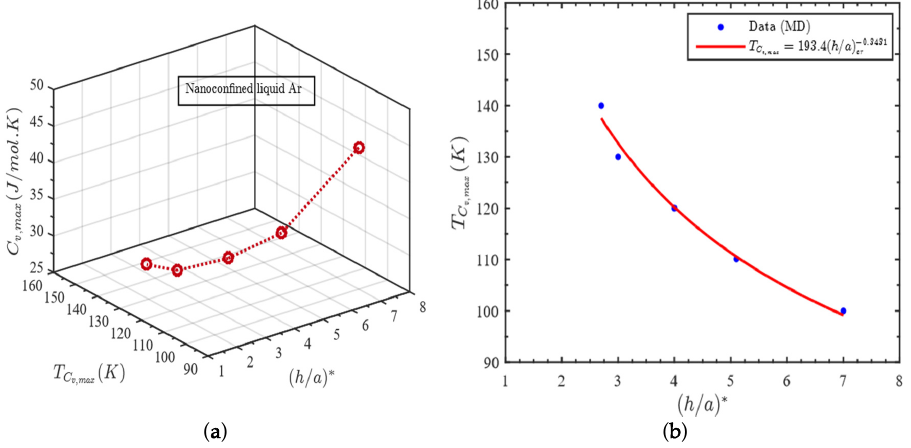
Figure 12. (a) Combined effect of gap thickness and temperature for maximum heat capacity of Figure 12. ( a ) Combined e ff ect of gap thickness and temperature for maximum heat capacity of nanoconfined liquid. ( b ) Relation between temperature and gap thickness for maximum heat